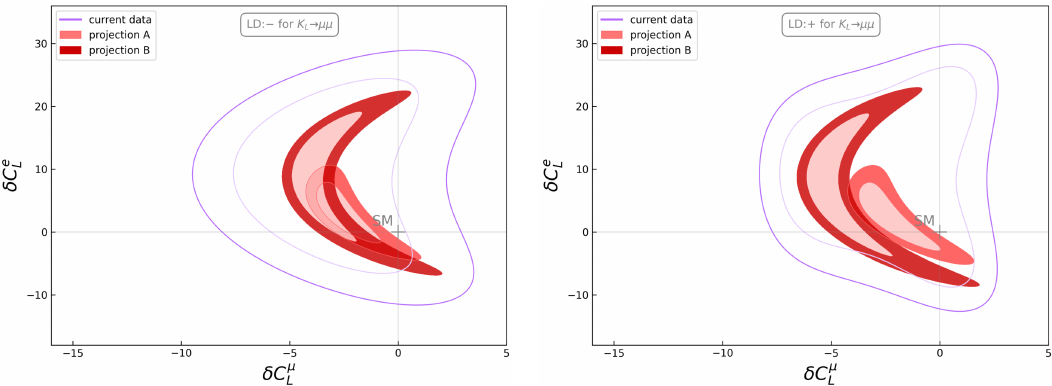
Figure 9 . Projected fit to rare kaon observables within 68 and 95% CL assuming negative (pos- itive) sign for the long-distance contribution to K L → µ ¯ µ on the left (right). Lighter shades of red: projection A with central values from current measurements (whenever there is one) or SM predictions (if currently not observed). Darker shades of red: projection B with current best-fit point used for all projections. The contours of the fit to current data (corresponding to the purple regions in figure 8) are shown with purple solid lines.